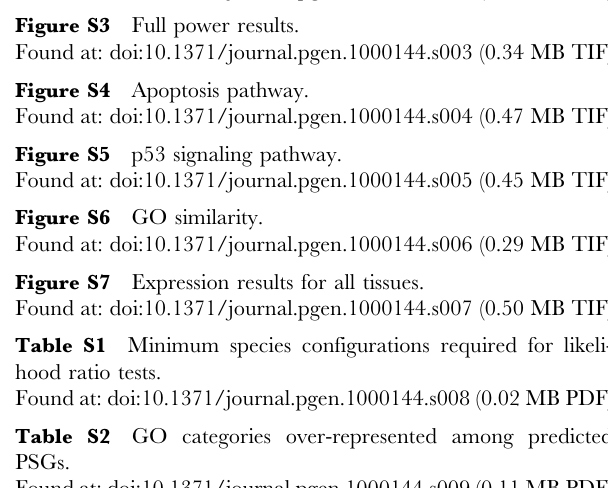
Table S3 PANTHER categories over-represented among pre- dicted PSGs. Text S1 Supplementary methods with complete set of